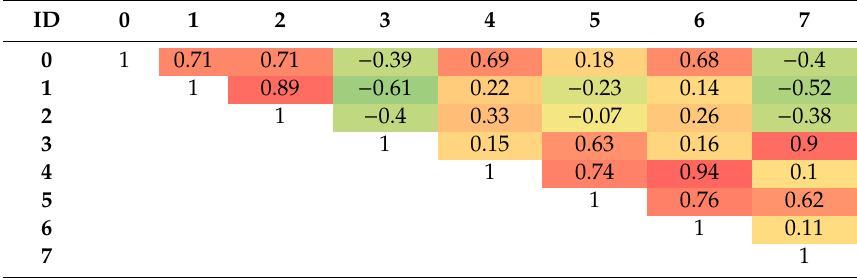
Figure 5. Inside Passage, Alaska study area. ( a ) Mean tidal current speed and ( b ) cross-correlation at points with mean velocity above 50 cm / s and deeper than 10 m with respect to the anchor point (0). Representative points for the correlation analysis are identified on both panels.